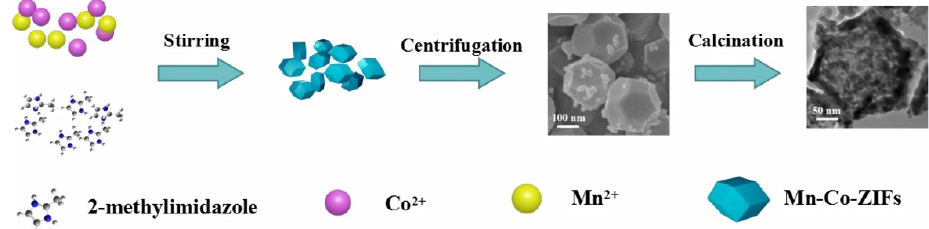
Figure 5. Preparation process of a nanocage MnCo 2 O 4 electrode. Reproduced with permission from Yanying Dong, Facile synthesis of hierarchical nanocage MnCo 2 O 4 for high performance supercapacitor; published by Elsevier, 2016 [89].